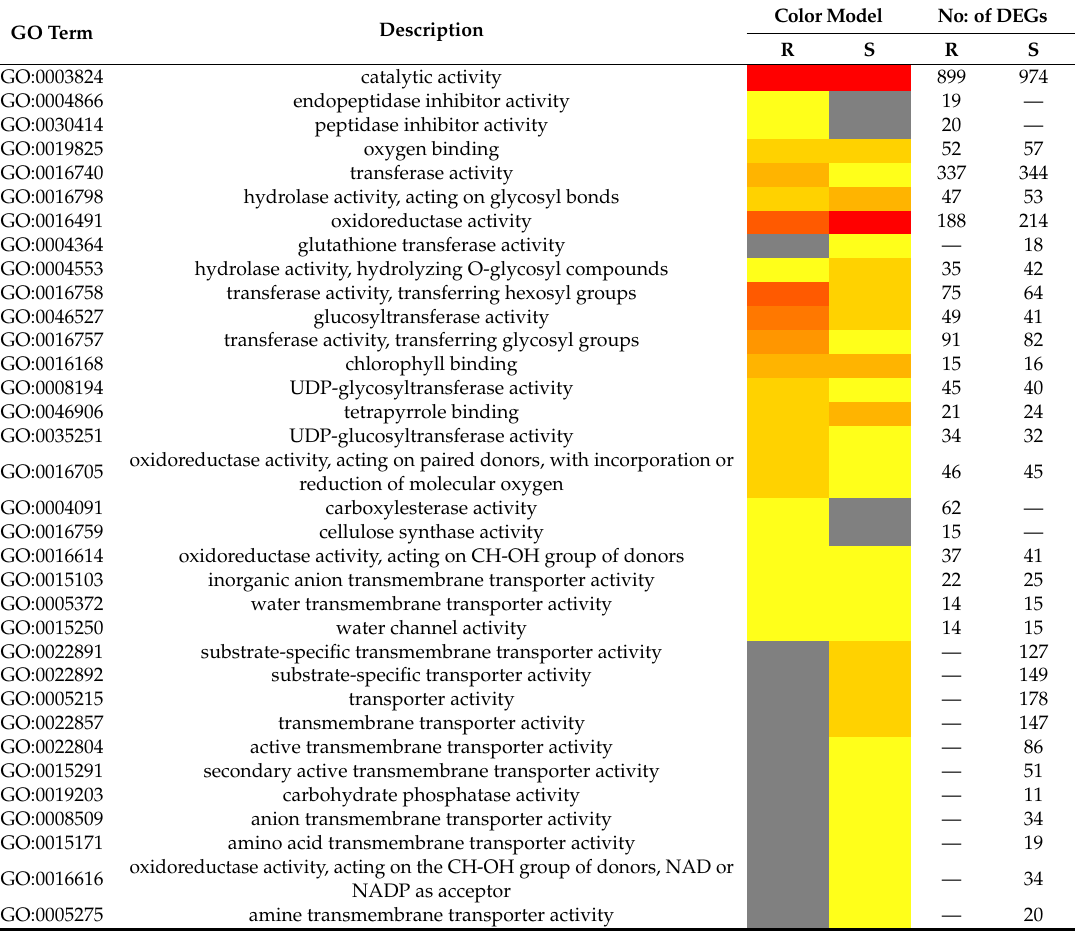
Table 2. Comparison of Gene Ontology (GO) term enrichment analysis (by SEACOMPARE) of DEGs found in P. parasiticat infected vs. control samples of both resistant (Sp-R) and susceptible (Sp-S) wild tomato